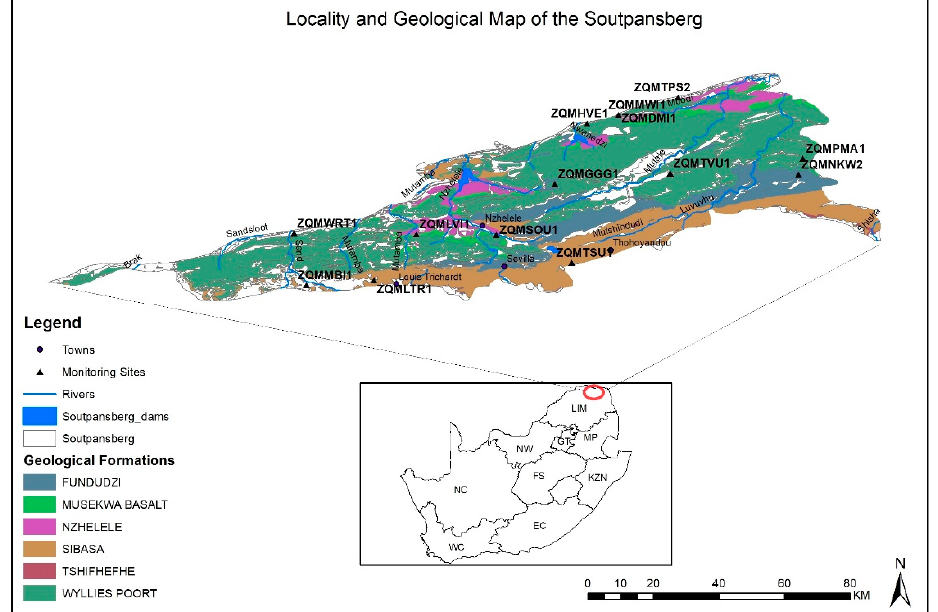
Figure 1. Locality and geological map of the Soutpansberg region with existing groundwater mon- itoring stations.